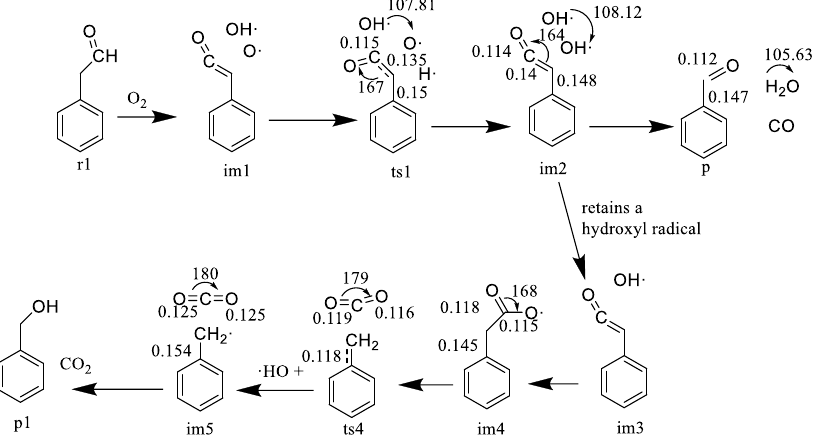
Figure 3. Structural model of aldehyde group and oxygen radical reaction (key length unit: nm; bond angle unit: °).